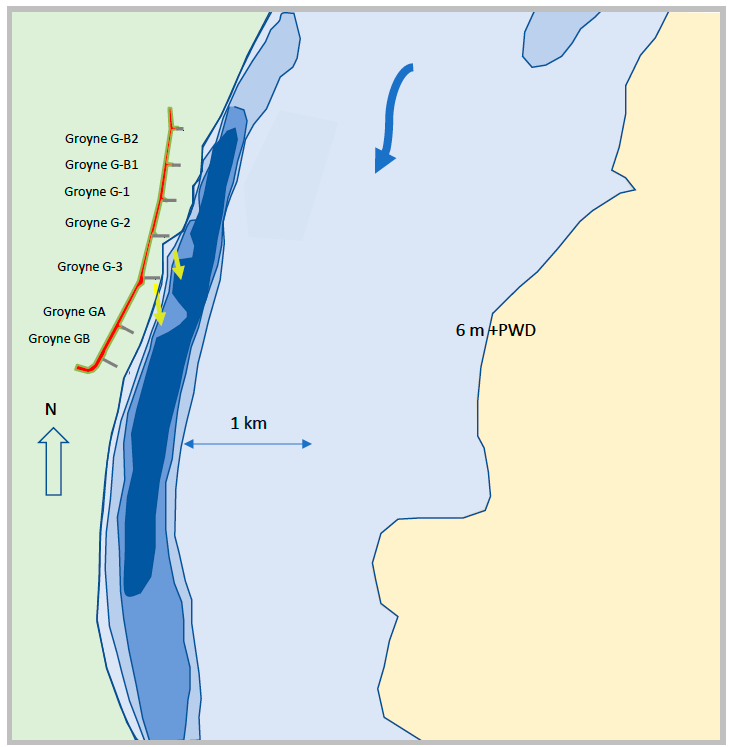
Figure 5. Outflanking channel Brahmaputra-Jamuna River and the groyne test structure at Kamarjani in August 1995, a few months after completion of the construction during (blue = water, dark blue = deep water < − 14 m + PWD, (PWD = Public Works Datum), green = land, yellow = char land, red = groyne test structure yellow arrows indicate the deposition after several flow slides) (sketch prepared by the